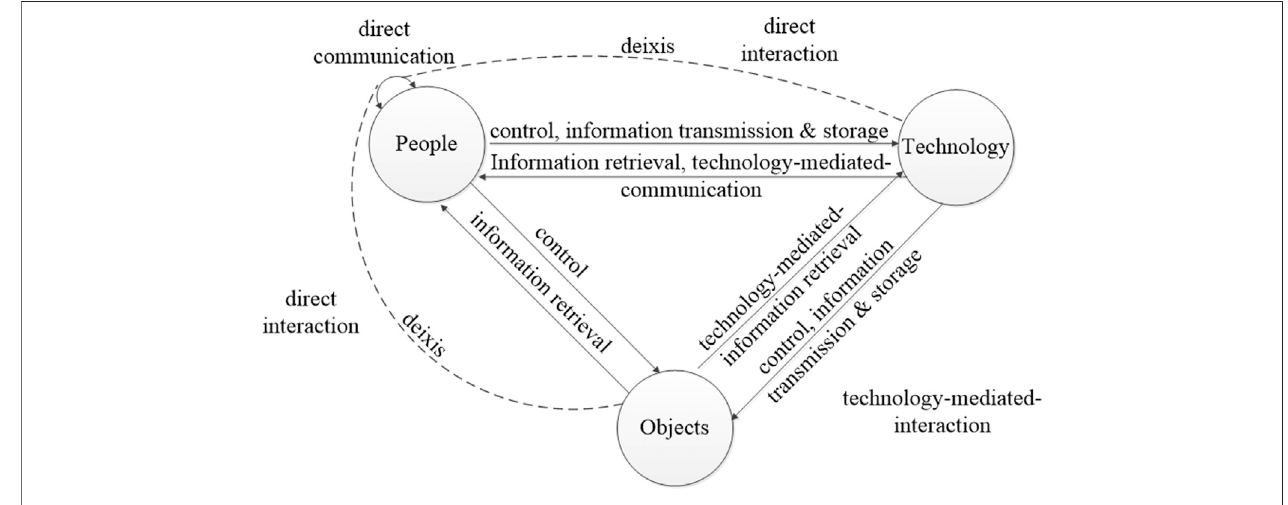
FIGURE 1 | The TEIF Architecture.